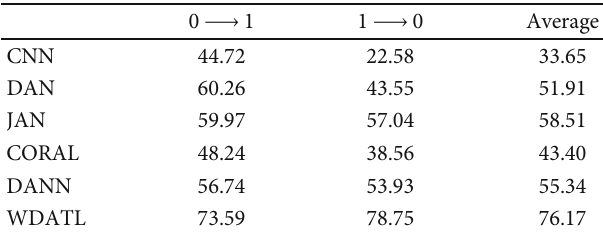
Table 6: Accuracy (%) for di ff erent methods in the SEU